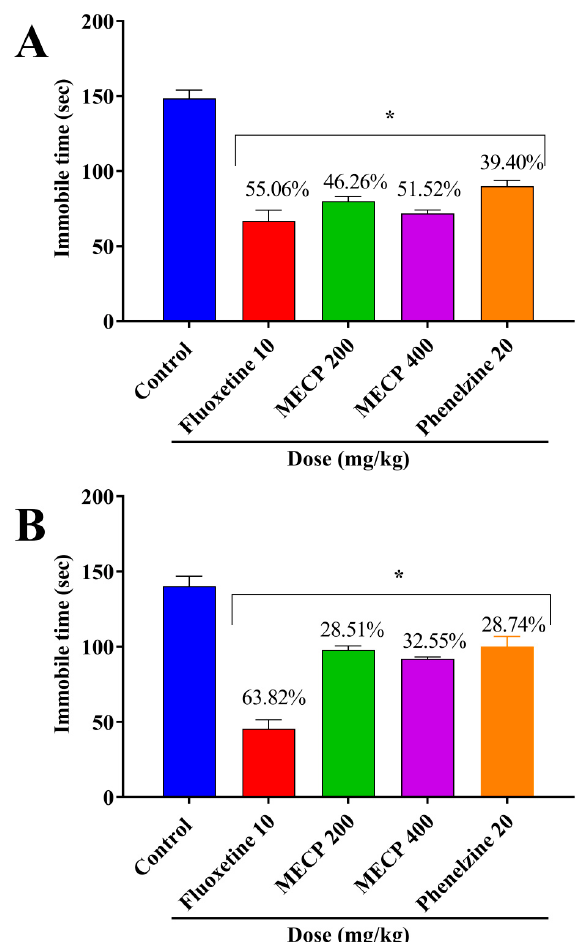
Figure 1. Antidepressant e ff ect of methanol extract of C. pectinata leaves (MECP), fluoxetine and phenelzine in tail suspension test ( A ) and forced swimming test ( B ). The values are shown as mean ± standard error of the mean (SEM). * p < 0.001 statistically significant compared with the control by Dunnett’s test ( n =